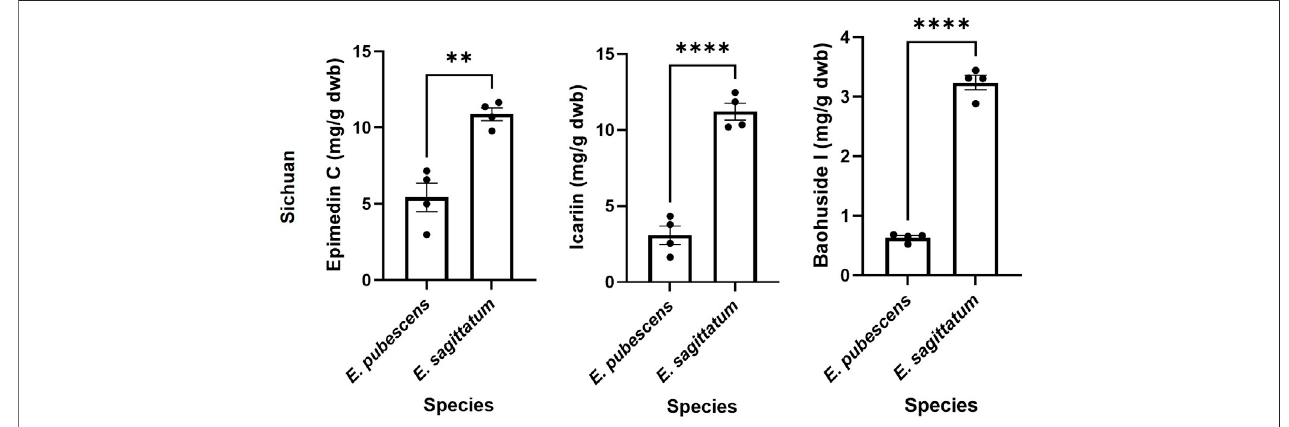
FIGURE6| Amount(mg/gdryweightbiomass)ofepimedinC,icariinandbaohuosideIofdifferentplantspeciescultivatedinsameplace(Wanyuan,Sichuan).Bars represent average ± SEM; dots represent individual data points. Statistically signi fi cant differences are represented by asterisks (** p < 0.01, **** p < 0.0001).